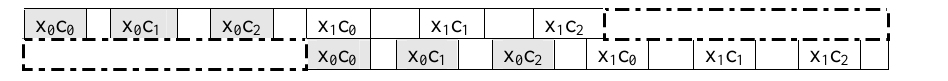
Figure 12: Secrecy of FH-DSSS